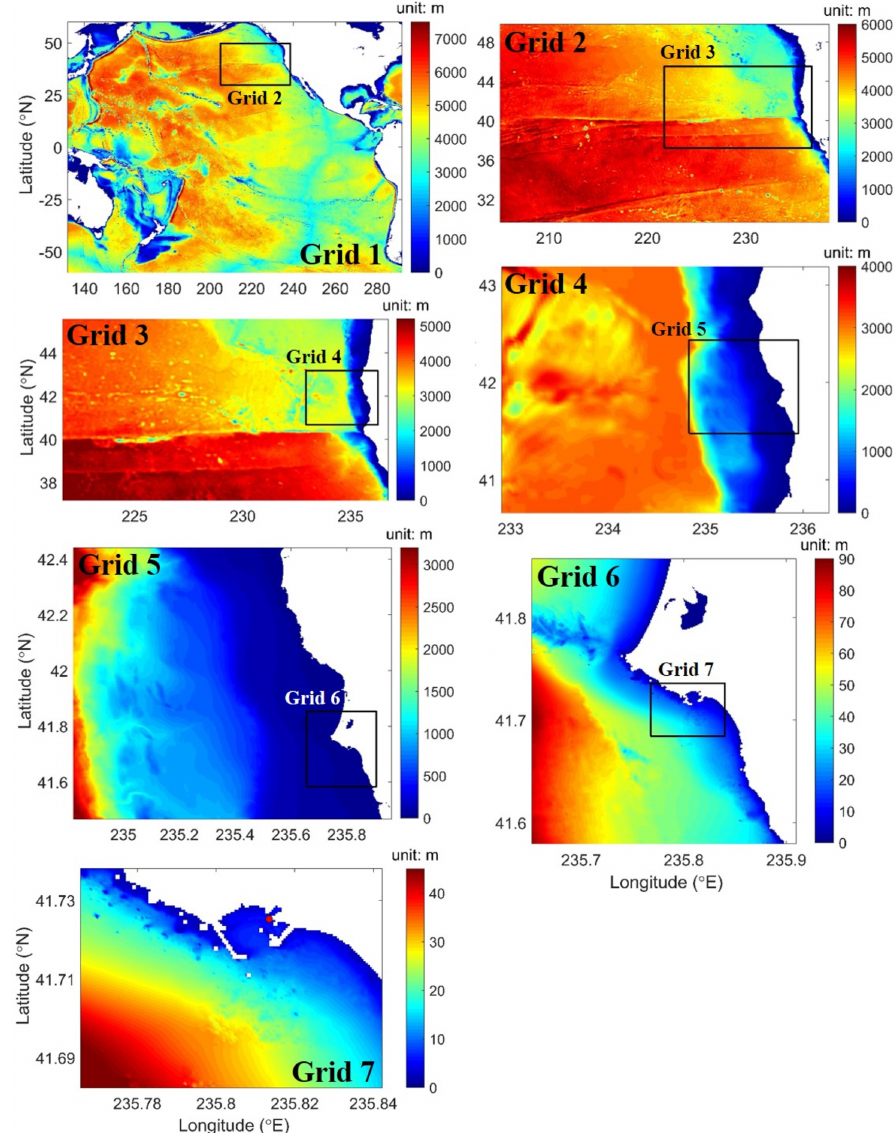
Figure 15. Nested-grid simulation of the 2011 Tohoku-Oki tsunami. Bottom topography and computational domains for Grids 1 to 7. Red circles in Grid 7 denote numerical wave gauge